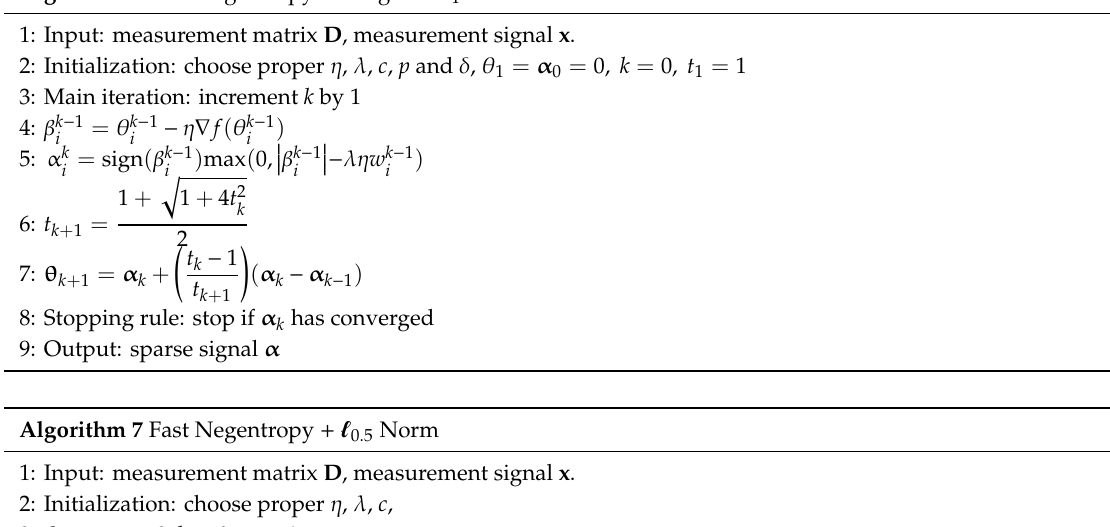
Algorithm 6 Fast Negentropy + Weighted (cid:96) 1 Norm